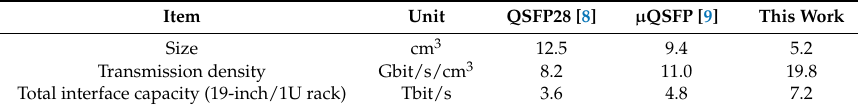
Table 1. Benchmark of form-factors for 4-ch active optical cables (AOCs).